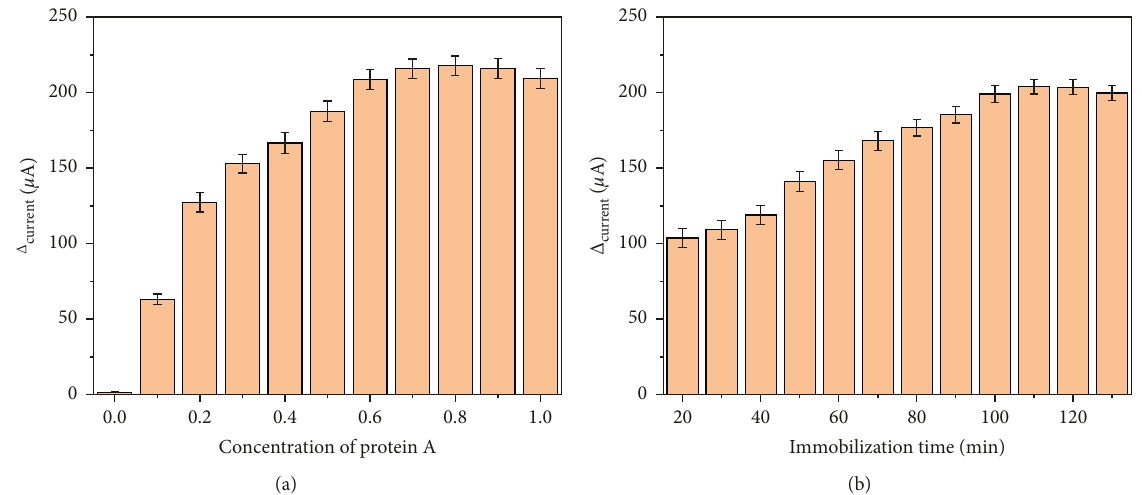
Figure 4: Effect of (a) the amount and (b) immobilization time of protein A in the sensor